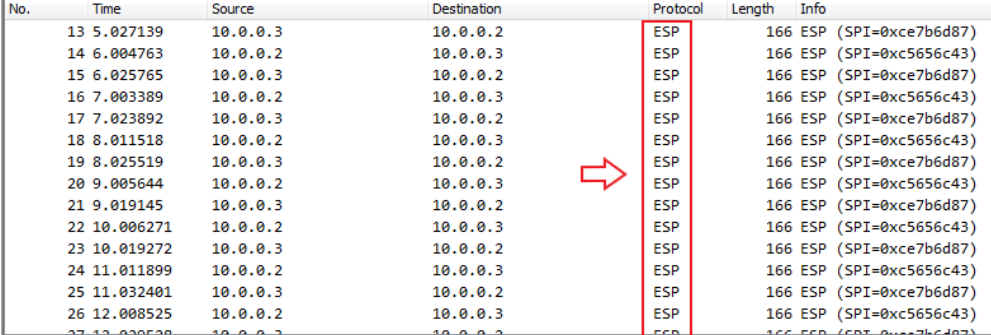
Figure 8. Site-to-site IPsec Virtual Private Network (VPN).